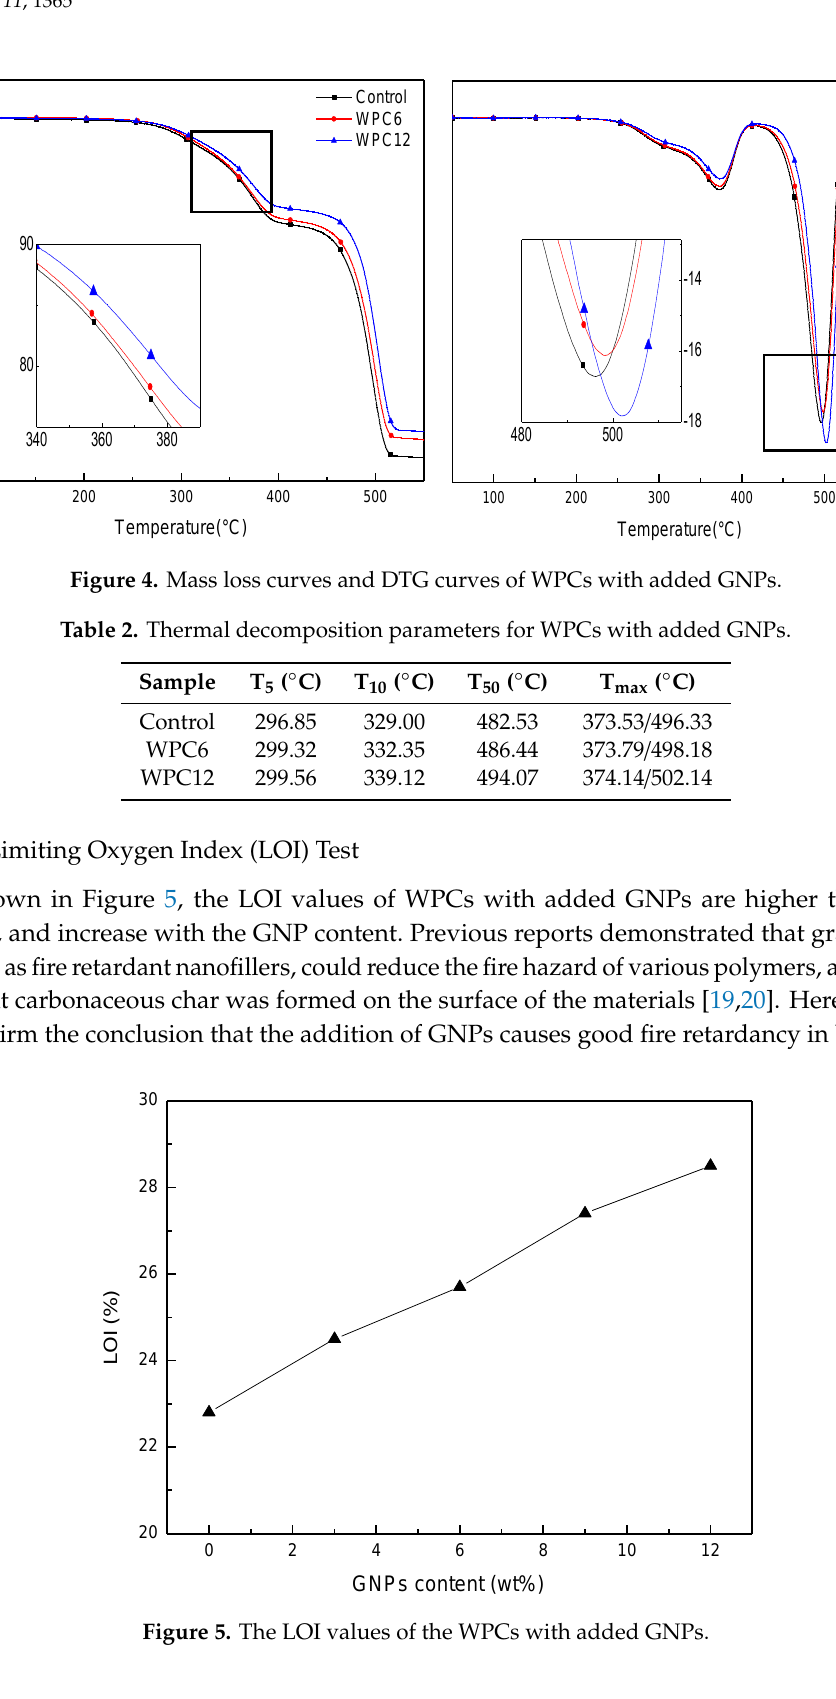
Figure 5. The LOI values of the WPCs with added GNPs.